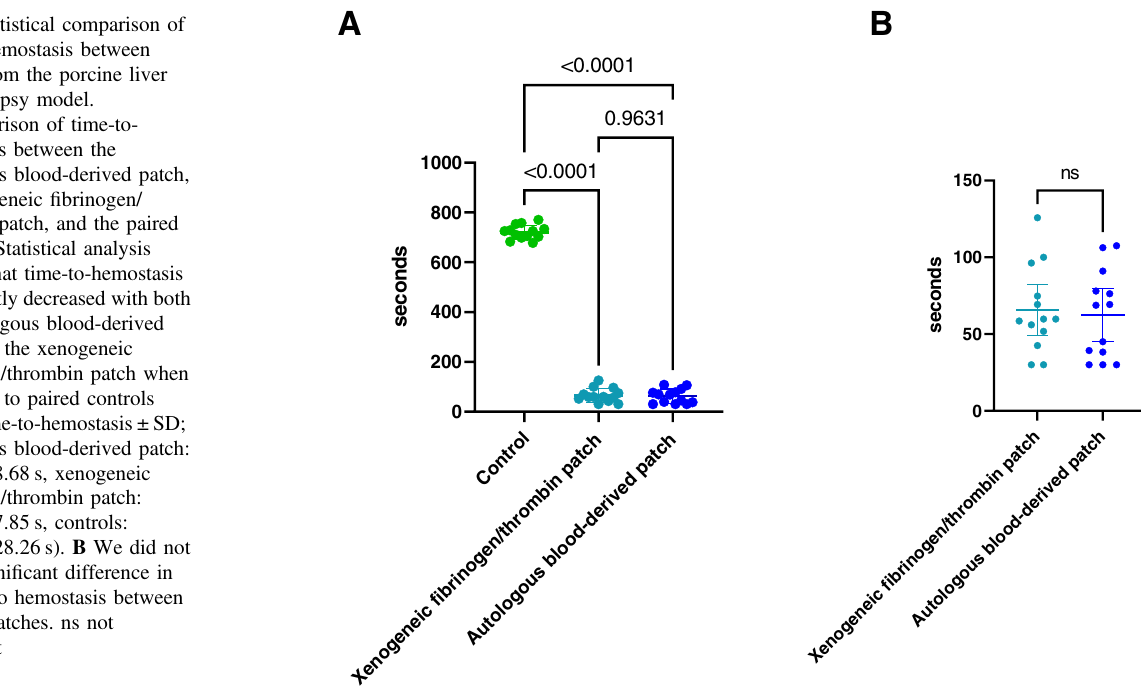
B Fig. 6 Statistical comparison of